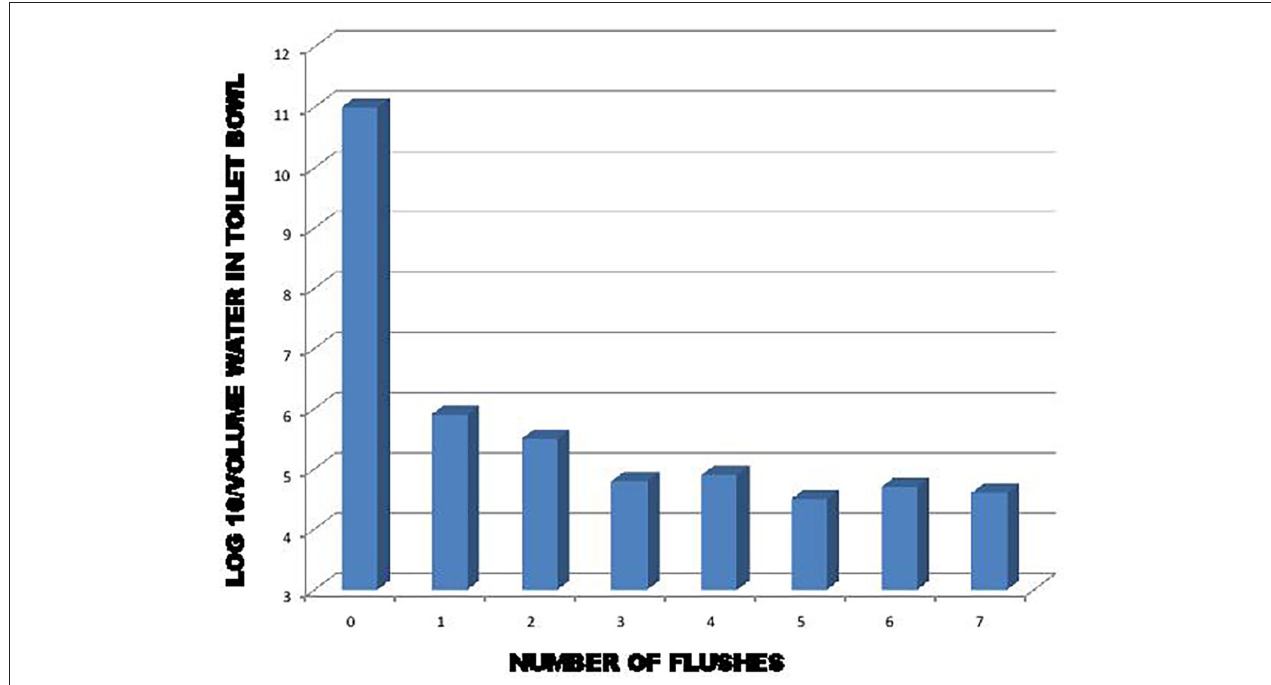
FIGURE 3 | Effect of flushing on removal of exogenously added bacteria and viruses to the toilet bowl